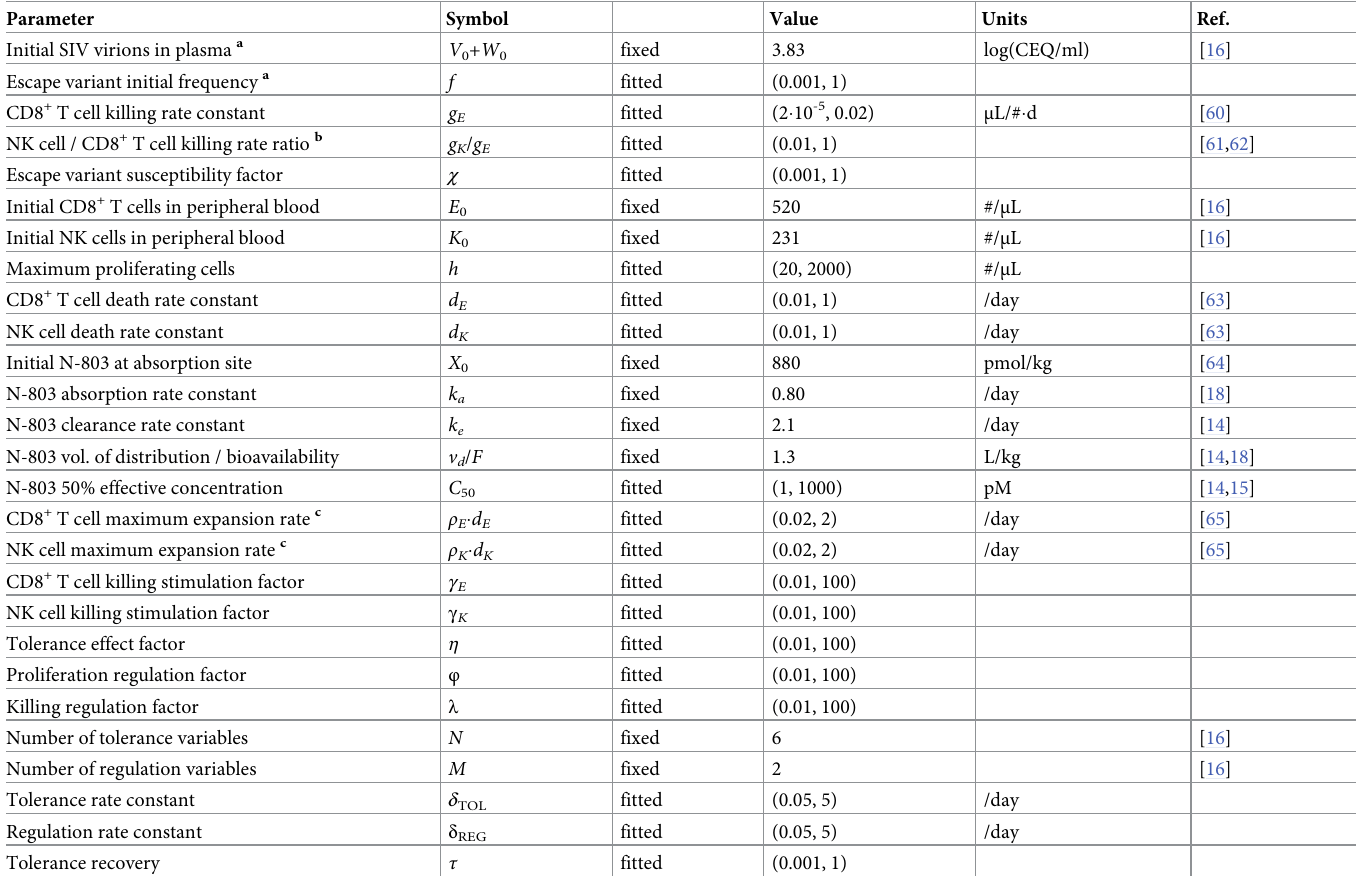
Table 3. Model parameters.